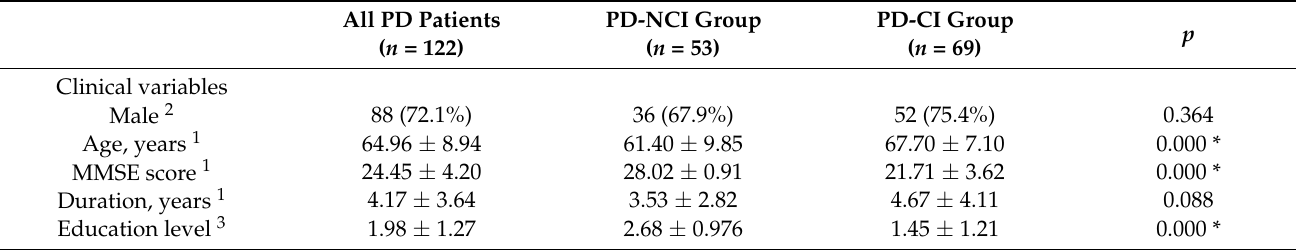
Figure 2. Flowchart of patient selection. PD, Parkinson's disease; MMSE, Mini-Mental State Examination; NCI, no cognitive impairment; CI, cognitive impairment; MRI, magnetic resonance imaging; CSVD, cerebral small vessel disease. Table 1. Comparison of clinical and neuroimaging